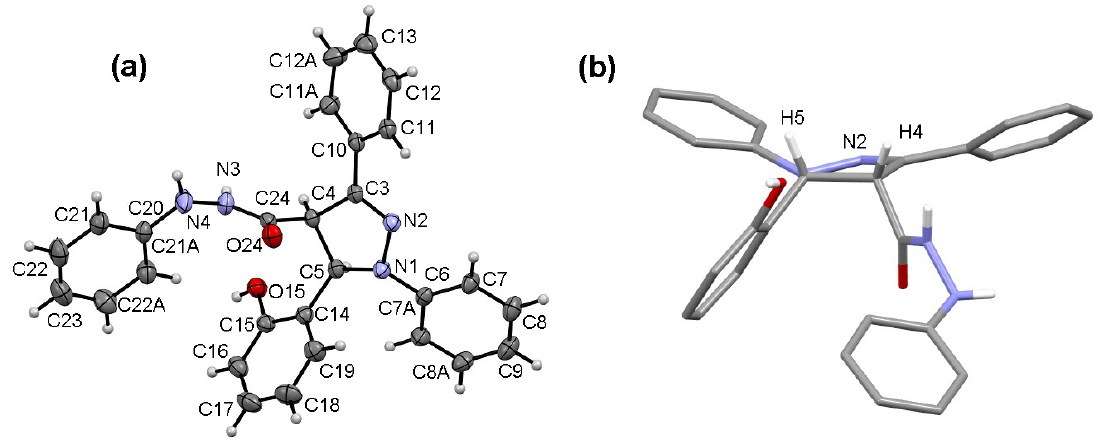
Figure 3. ( a ) Ortep plot at 50% probability level of the DMSO (not shown) solvate of compound 2a - (4 R , 5 R ) enantiomer. ( b ) Stick plot of compound 2a —view through the 4,5-dihydro-pyrazole ring— to appreciate the steric effect of the four phenyl rings and the cis disposition between H4 and H5.